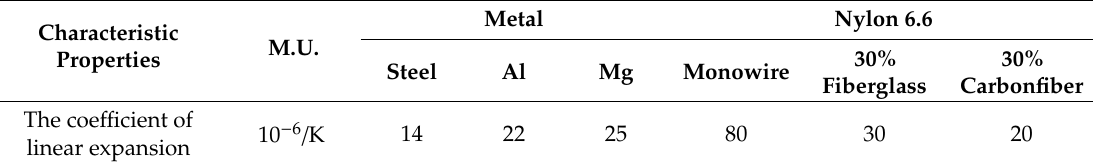
Table 1. The coe ffi cient of linear expansion [4]. Table 1. The coefficient of linear expansion [4].